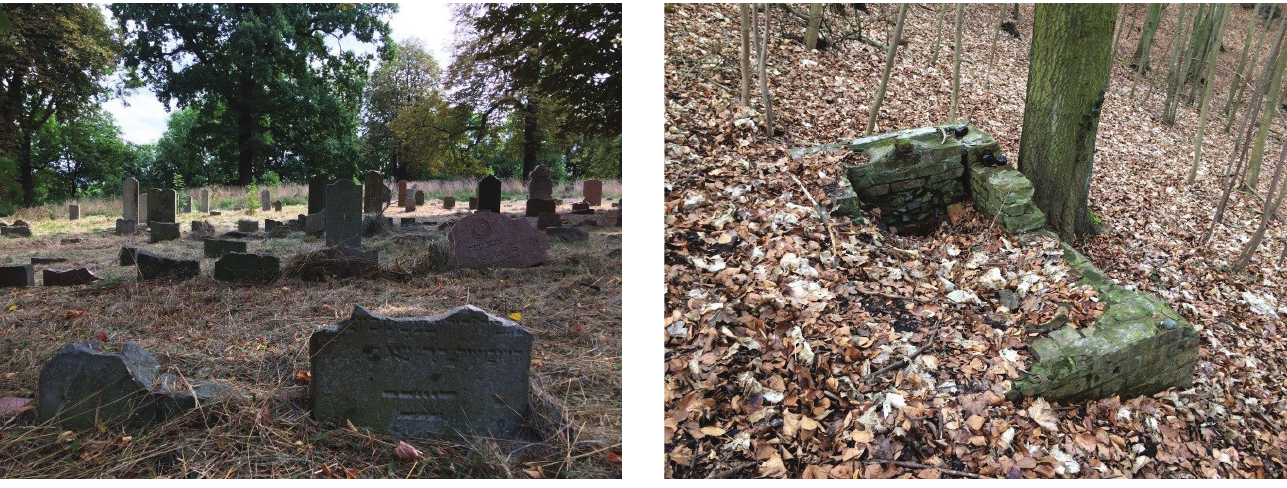
Figure 10: Neglected Jewish cemetery. Photo: K.